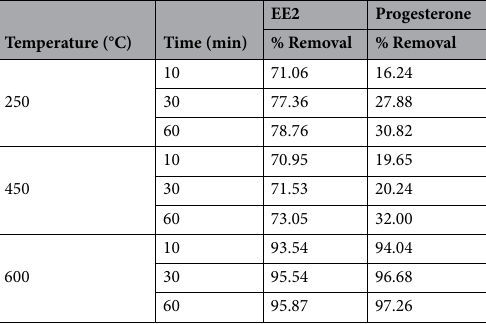
Table 1. Removal capacity of the biochar in the pilot batch test for the three different pyrolysis temperatures.